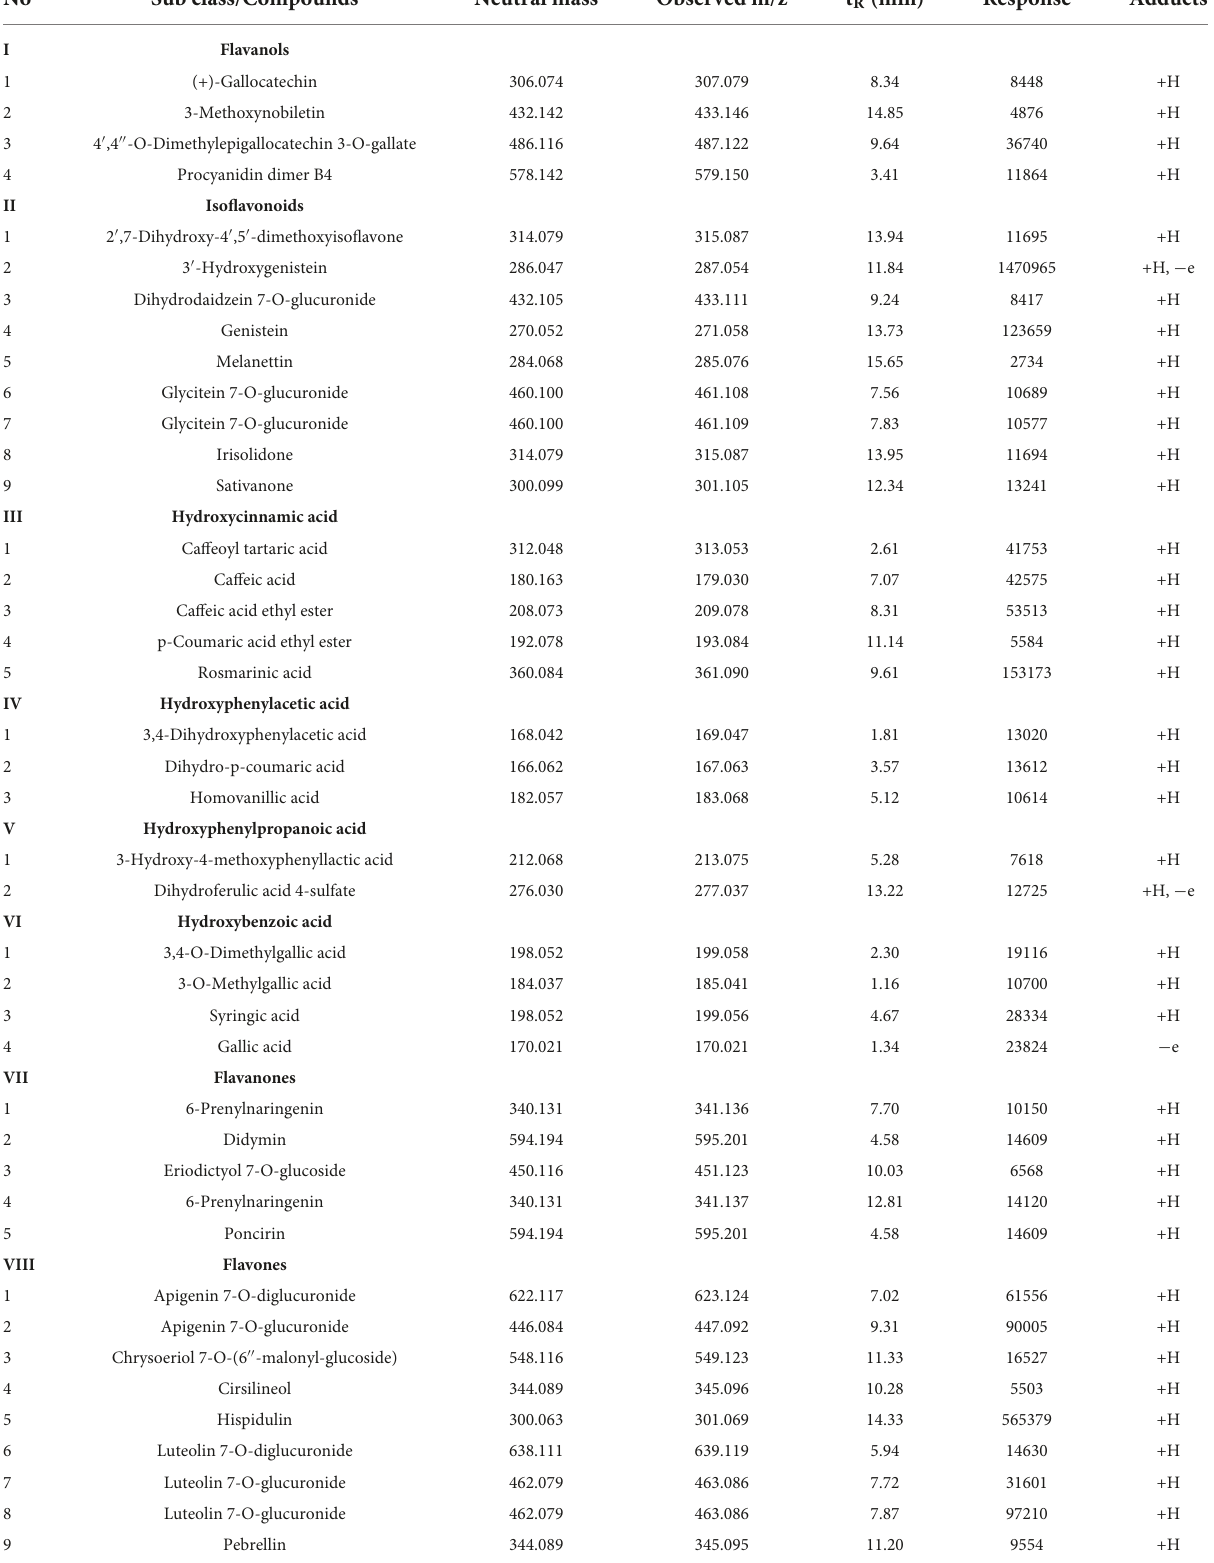
TABLE 2 Characterization and classification of phenolic compounds in Perilla seed meal